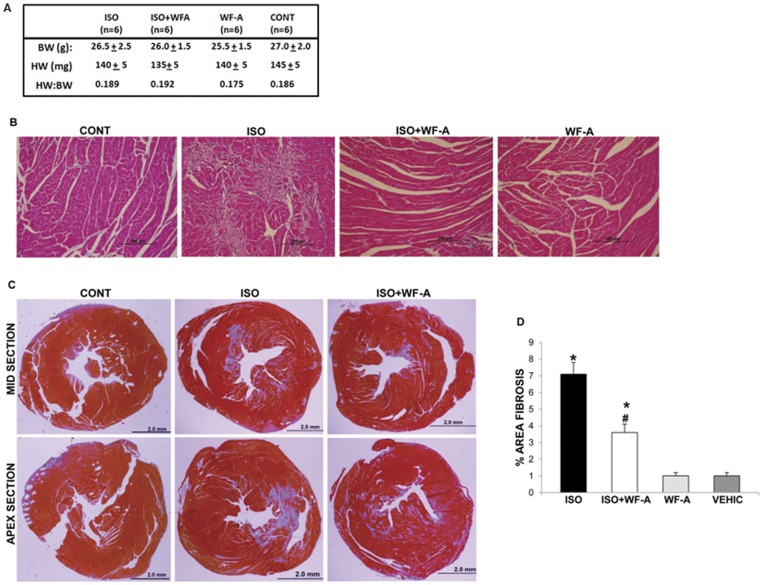
WF-A inhibits isoproterenol induced myocardial fibrosis in mice.A. Mice were injected with isoproterenol (ISO), isoproterenol + WF-A (ISO+WF-A), WF-A alone or vehicle (CON). Heart weight (HW) to body weight (BW) ratio (HW:BW) is shown as the mean ±1 SEM. B. WF-A protects against necrosis of heart tissue. H&E staining of a representative section of a heart from the control group (CONT), isoproterenol group (ISO), isoproterenol + WF-A group (ISO + WF-A) and WF-A group (WF-A). Scale bar: 200 µm. C. WF-A decreases isoproterenol induced myocardial fibrosis in mice. Masson’s trichrome staining of the base of the ventricle sections of hearts of control mice and mice treated with ISO and with ISO+WF-A. Two representative sections of each heart are shown with collagen staining in blue. Scale bar: 2 mm. D. Morphometric analysis of the percentage of fibrotic area of the hearts. Fibrosis areas within the sections (blue) were quantified using Image J software. The percentage of fibrosis was estimated from the ventricular and apex sections of each heart. Data represent ±1 SEM of six mice per group. * represents p<0.05 and # represents p<0.01.